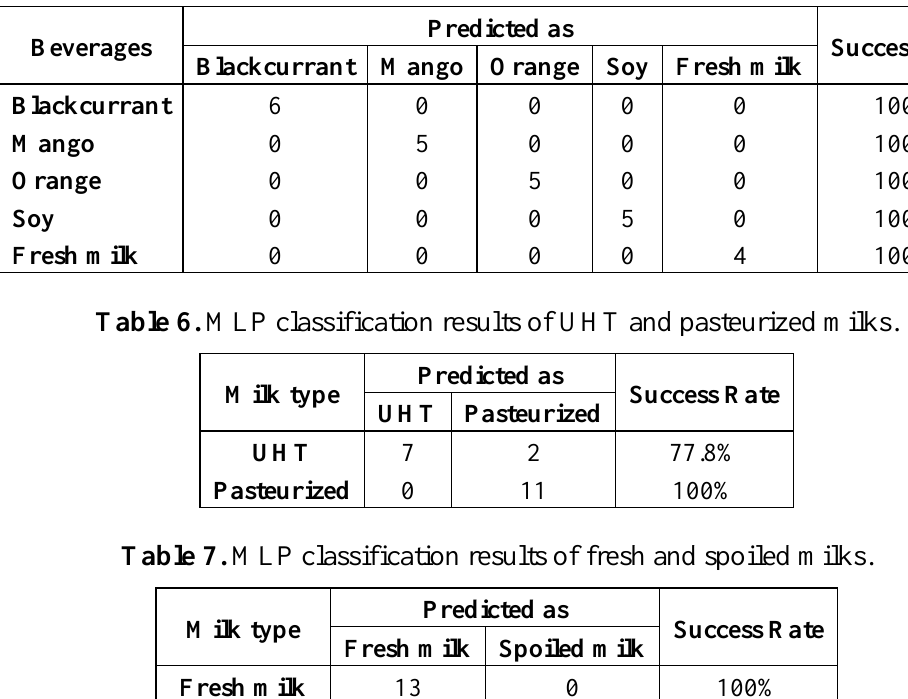
Table 5. MLP classification results of five beverages.